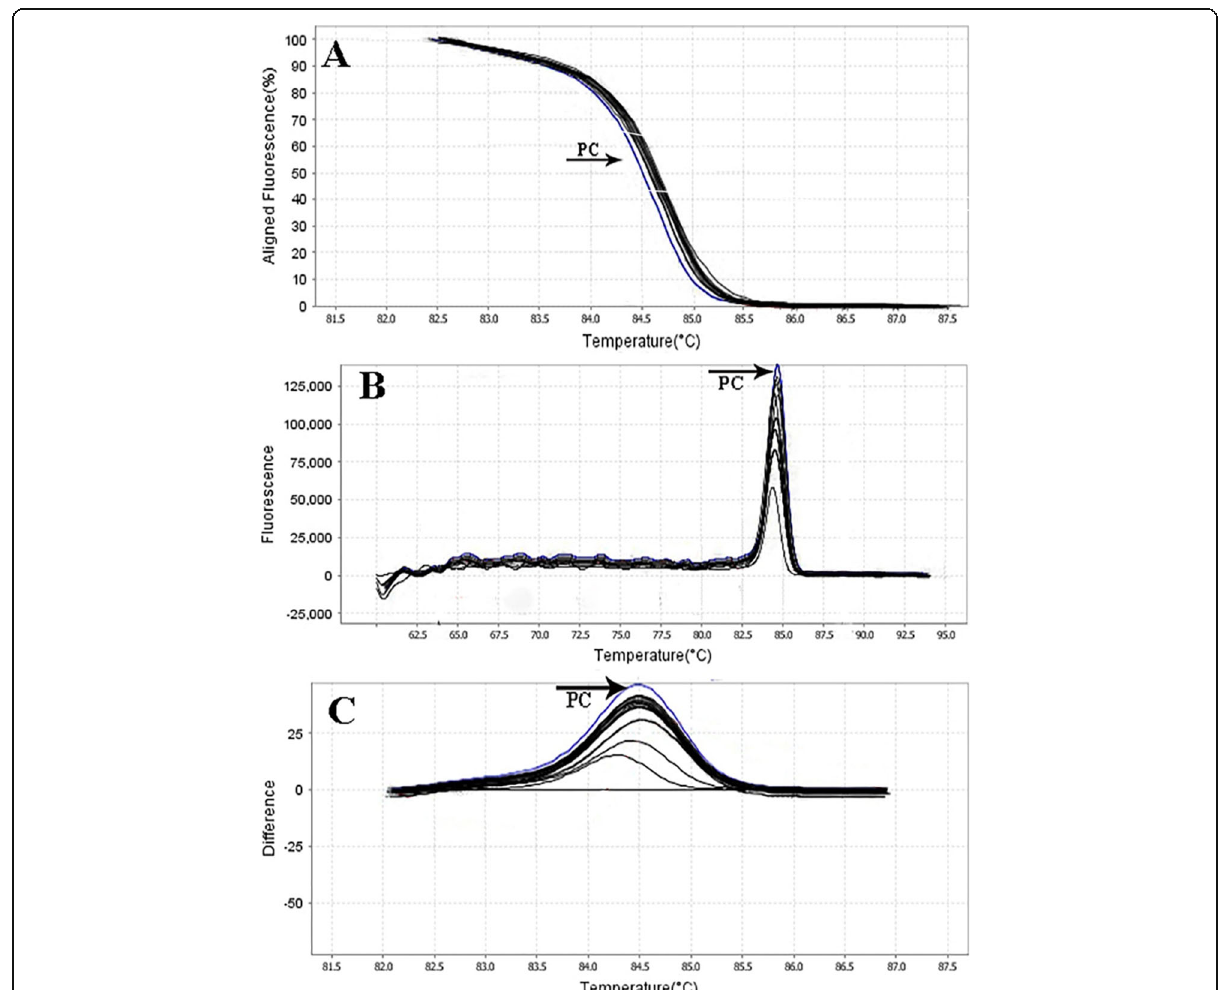
Fig. 5 HRMA graphs corresponding to one high-resolution melting analysis of a subset of clinical specimens ( n = 8). Curves of tested samples previously identified as E. faecium are shown in black lanes. DNA samples in this study were prepared and amplified successfully using the EvaGreen dye-based method in the ABI instrument. Primer-specific melting peaks (Tm) were obtained via HRM analysis, allowing the differentiation of all investigated β -lactamase enzymes. Due to the highly saturating EvaGreen dye and the HRMA analysis, the accuracy of the resolution was ± 0. 1 – 0.5